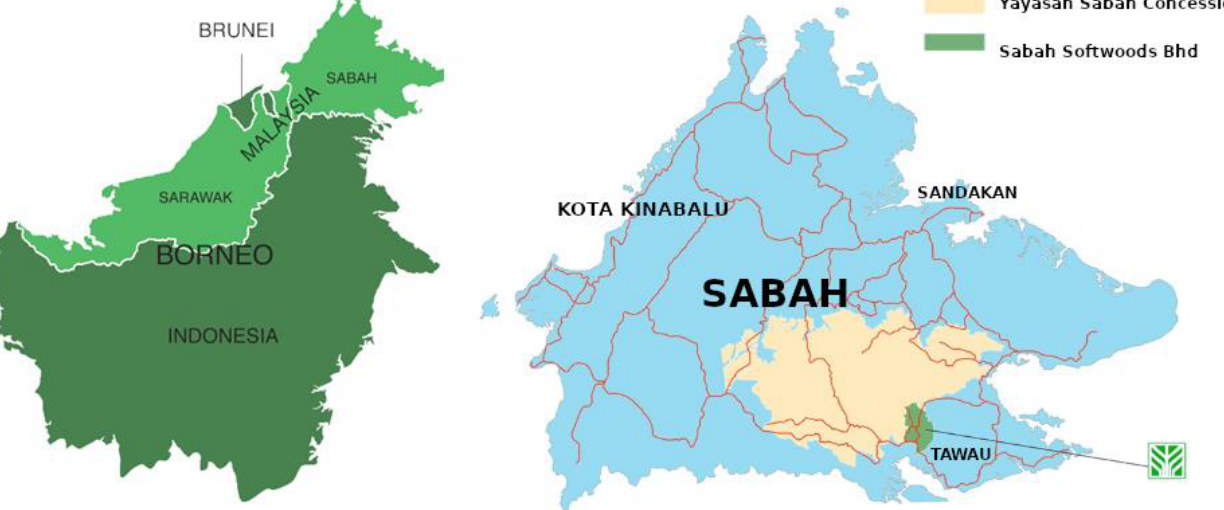
Figure 1. Location of the Sabah Softwoods Berhad, Brumas Estate, and location of Sabah within Borneo.